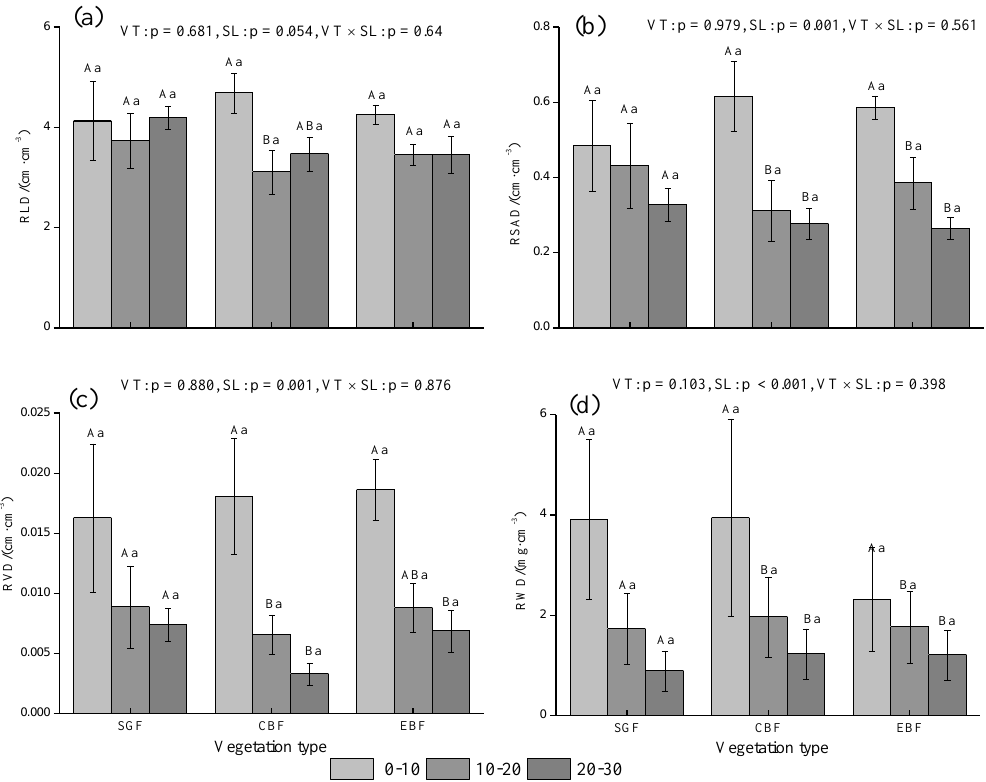
Figure 3. Parameters of root characteristics of three vegetation types and three soil layers (mean ± SE, n = 4), SE is the variance of the index. The error line indicates standard error; upper case letters indicate a significant difference among different soil layers of the same land use types ( p < 0.05); the lower case letter indicates a significant difference between different land use types of the same soil layer ( p < 0.05). EBF stands for evergreen broad-leaved forest; CBF stands for mixed forest; SGF stands for shrub-grass forest; RLD stands for root length density; RSAD stands for root surface area density; RVD stands for root volume density; RWD stands for root weight density; VT stands for vegetation type; SL stands for soil layer. Two-way ANOVA was applied to indicate significant differences between variances. ( a ) shows the RLD in different soil layers in different stands; ( b ) shows the RSAD in different soil layers in different stands; ( c ) shows the RVD in different soil layers in different stands; ( d ) shows the RWD in different soil layers in different stands. Compared with broad-leaved forest and grassland, the coniferous and broad-leaved mixed forest had the lowest root length density (RLD), RSAD, and RVD in the 10–20 cm and 20–30 cm soil layers, while the RWD was just the opposite, with no significant differ- ence. The RLD, RSAD, and RWD in the 0–10 cm soil layer of the mixed coniferous and broadleaved forest were the highest; however, the difference was not significant. 3.4. Shear Strength Parameters of Root Soil The internal friction angle and cohesion of the different classes of soil were signifi- cantly different ( p < 0.05) (Figure 4a,b). In different soil layers, the internal friction angle of mixed coniferous and broad-leaved forest was significantly lower than that of the grass- land and native broad-leaved forest, while the internal friction angle of broad-leaved for- est was the largest (Figure 4a). Moreover, the cohesiveness of the broad-leaved forest soil was significantly lower than that of the mixed broad-leaved forest and grassland (Figure 4b). Except for the 10–20 cm soil layer, the soil cohesiveness of the mixed broad-leaved forest and grassland were the largest, while that of the other soil layers was grassland.